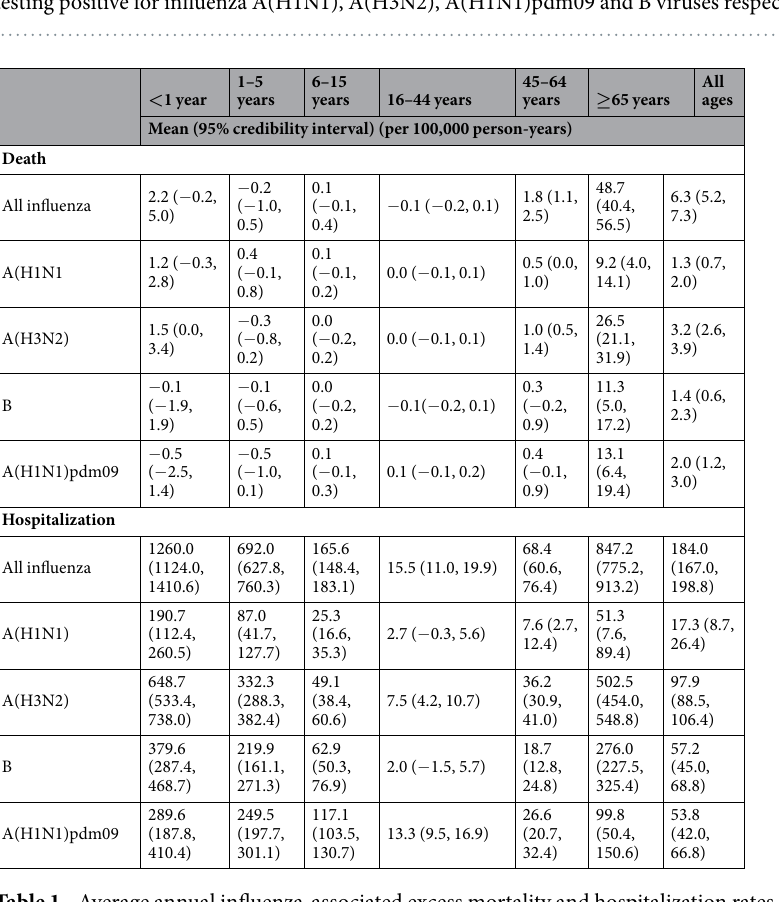
Figure 1. Weekly influenza virus activity in Hong Kong from 1998 through 2013, measured by ILI + proxies defined for each influenza type/subtype as the product of the weekly proportion of outpatient consultations associated with influenza-like-illness in sentinel clinics and the weekly proportions of laboratory specimens testing positive for influenza A(H1N1), A(H3N2), A(H1N1)pdm09 and B viruses respectively.